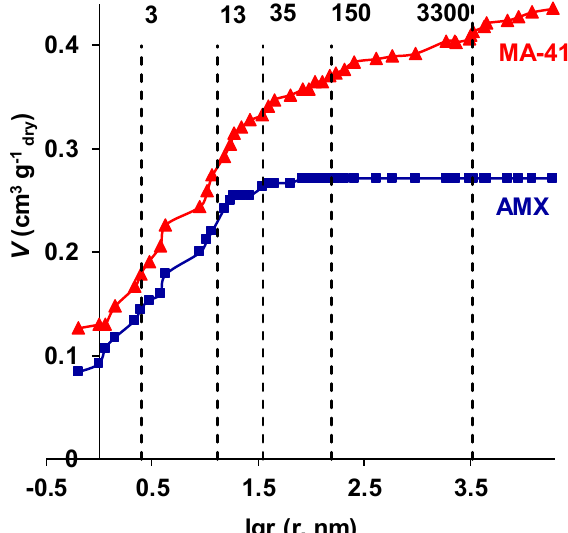
Figure 6. The dependence of the volume of sorbed water ( V ) on the effective pore radius (r) in an AMX and a МА -41 membrane. The vertical dashed lines indicate the inflection points on the curves; these points correspond to the radii of the pores whose fraction in the membranes is relatively high. The values (in nanometers) of these radii are shown by the numbers near the dashed lines.